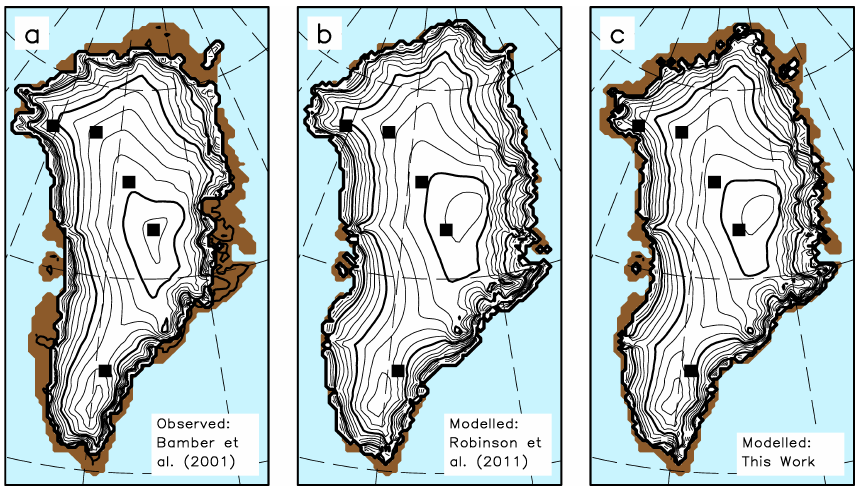
Figure 9. Present-day Greenland ice sheet topography. (a) Observed data compilation by Bamber et al. (2001). (b) Simulation after Robinson et al. (2011). (c) Simulation from present work, given the parameter combination with smallest error in err( H ), i.e. c d = 1.4, c m =− 60Wm − 2